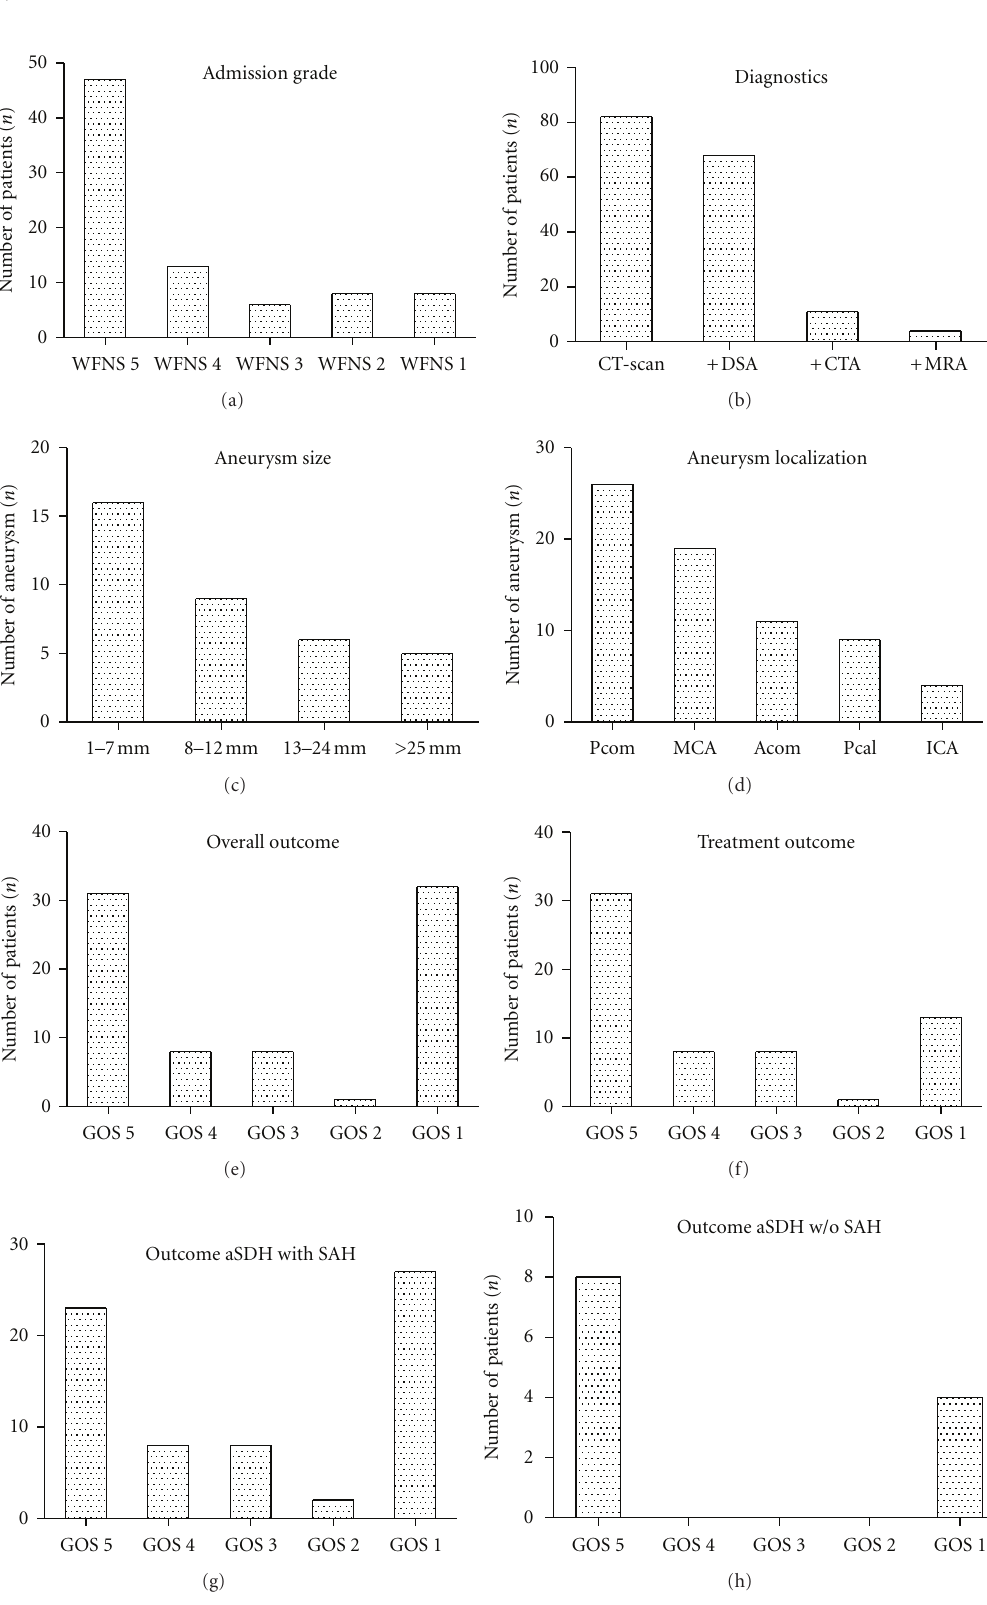
Figure 1: Data analysis of 82 cases of aneurysmal aSDH ∗ . ∗ Abbreviations: WFNS = World Federation of Neurological Surgeons; CT = computed tomography; DSA = digital subtraction angiography; CTA = CT angiography; MRA = Magnetic resonance angiography; mm = millimeter; Pcom = posterior communicating artery; MCA = middle cerebral artery; Acom = anterior communicating artery; Pcal = pericallosal artery; ICA = internal carotid artery; GOS = Glasgow Outcome